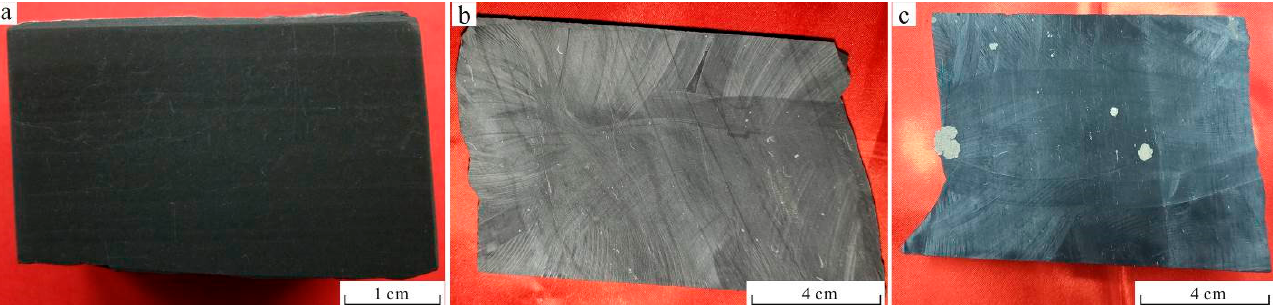
Figure 3. Core photographs from ( a ) SH outcrop (sample number: SH5-26-2), ( b ) well YH3-8 (sample number: YH-236), and ( c ) well Z204 (sample number: Z4-8) showing characteristics of the Wufeng - Longmaxi shale (For the locations of the wells and outcrop, the reader is referred to Figure 1 of this article).